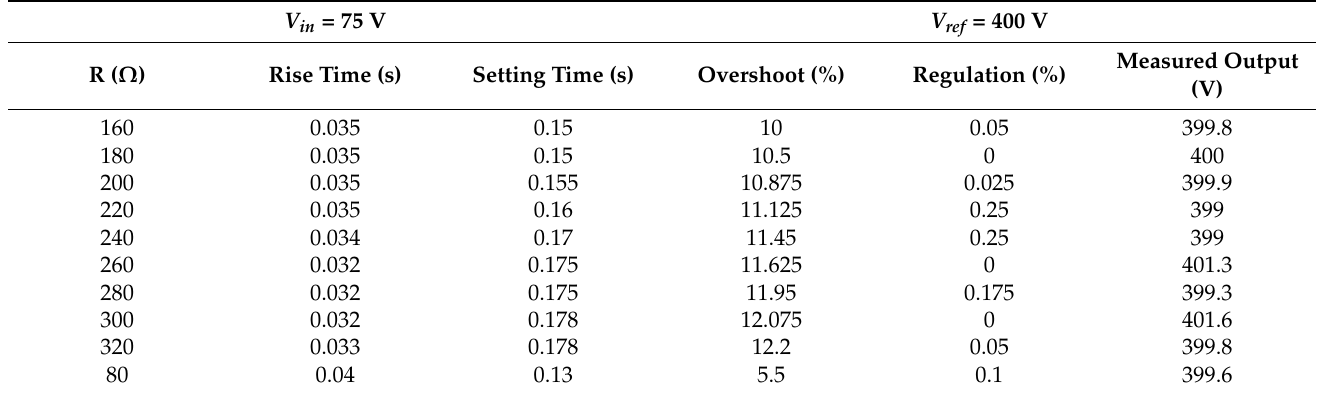
Table 2. Performance parameters of proposed HG-SIQBC for V in = 75 V.